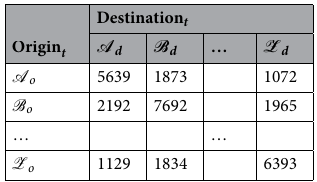
Table 1. Origin-destination: (OD)